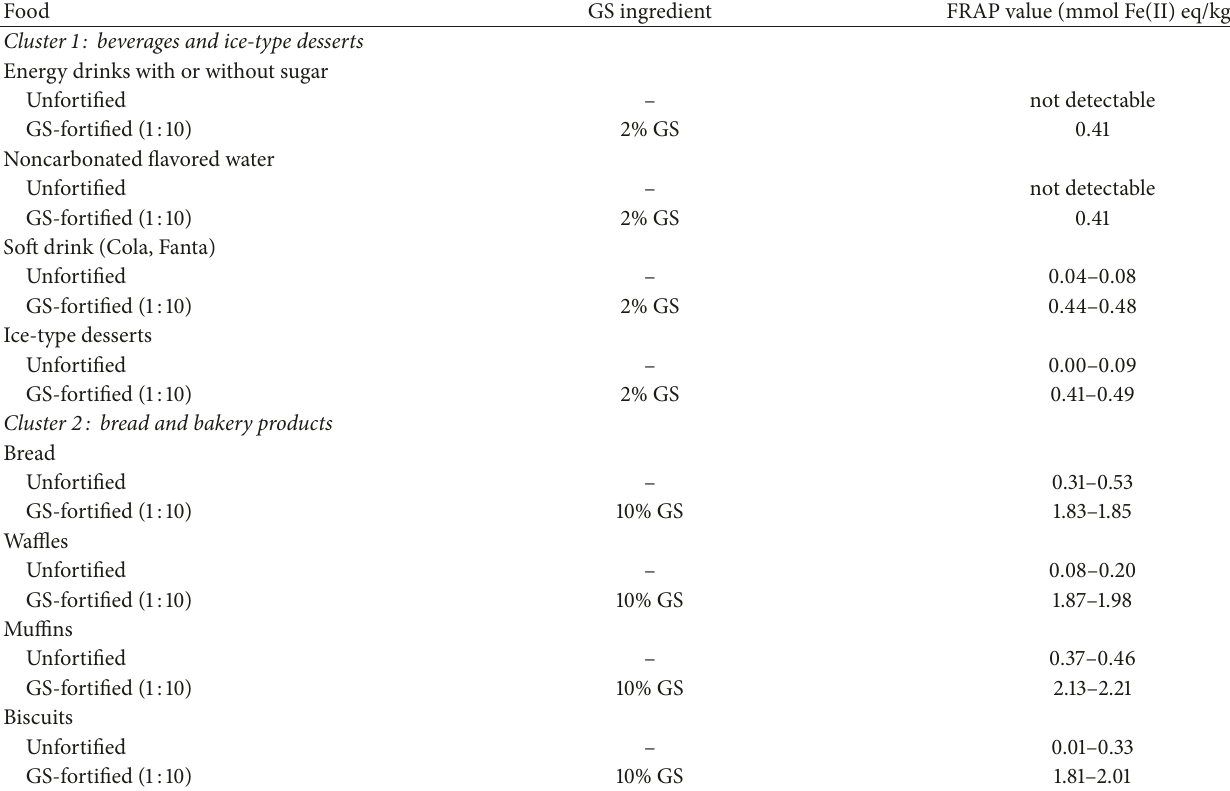
Table 5: Potential ability of semiliquid food ingredients recovered from GS to increase the FRAP values (mmol Fe(II) eq/kg) of various foods ∗ .